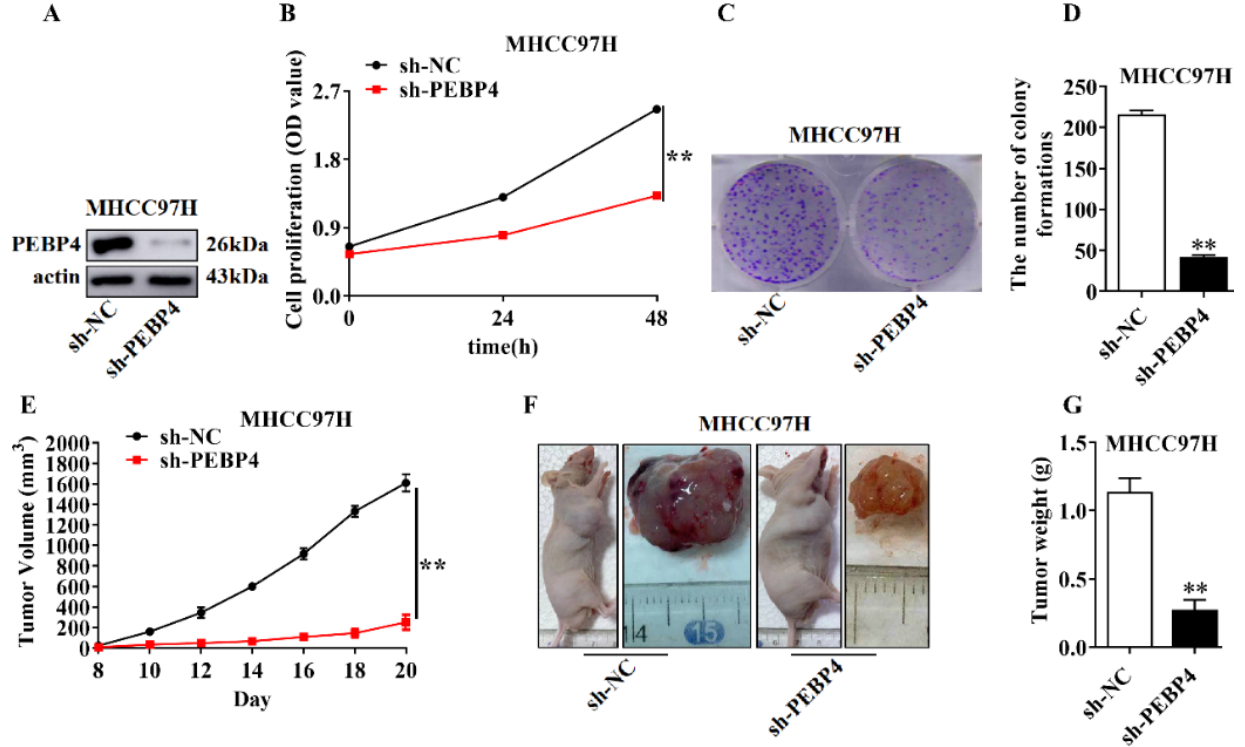
Figure 4. Knockdown of PEBP4 suppresses the growth of HCC. ( A – D ) MHCC97H cells containing sh-PEBP4 or sh-NC were examined by WB ( A ), cell proliferation ( B ), and colony formation ( C , D ). Colonies in triplicate were counted ( D ). ( E ) BALB/C nude mice (n = 5) were injected into right fossa axillaris with the cells as indicated in ( A ) and tumor volumes measured. ( F , G ) Mice were sacrificed after 20 days and tumors were weighed ( G ). Representative images of mice and isolated tumors ( F ) were presented. All quantitative measurements were presented as mean ± SEM and statistical significance was tested, ** p < 0.01.